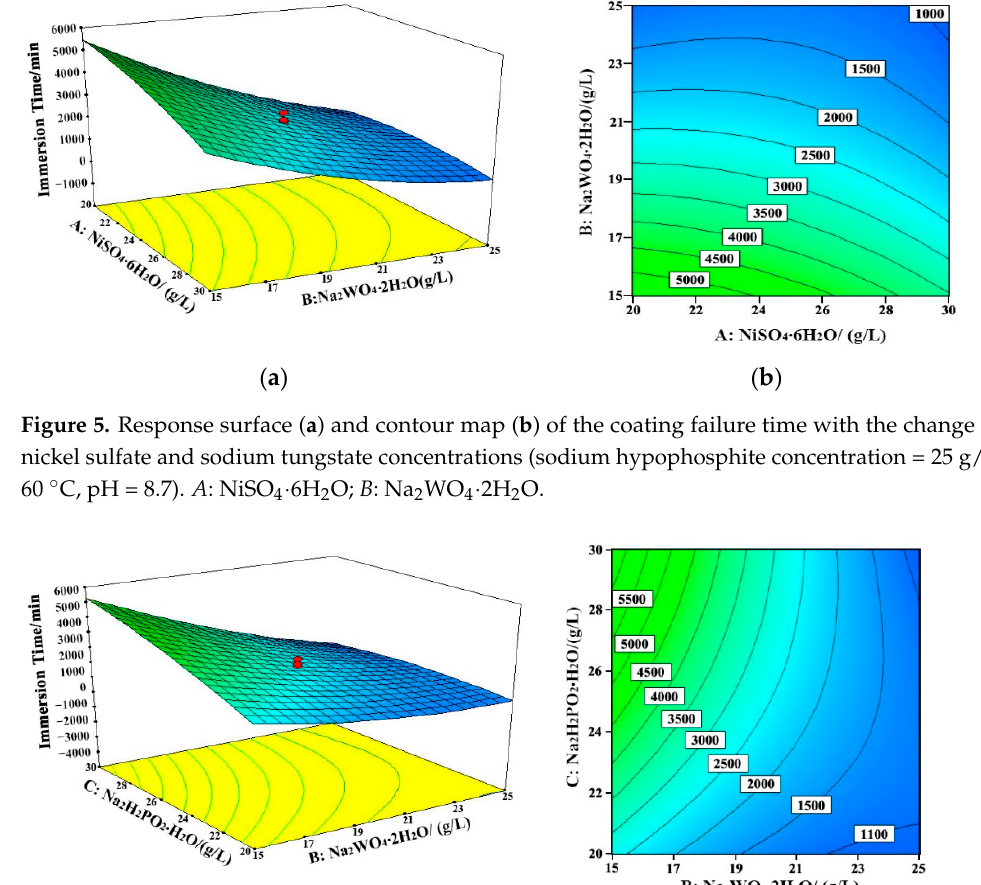
Figure 6. Response surface ( a ) and contour map ( b ) of the coating failure time with the change of sodium tungstate and sodium hypophosphite concentrations (Nickel sulfate concentration = 25 g/L, 60 °C, pH = 8.7). B : Na 2 WO 4 ·2H 2 O; C : NaH 2 PO 2 ·H 2 O.